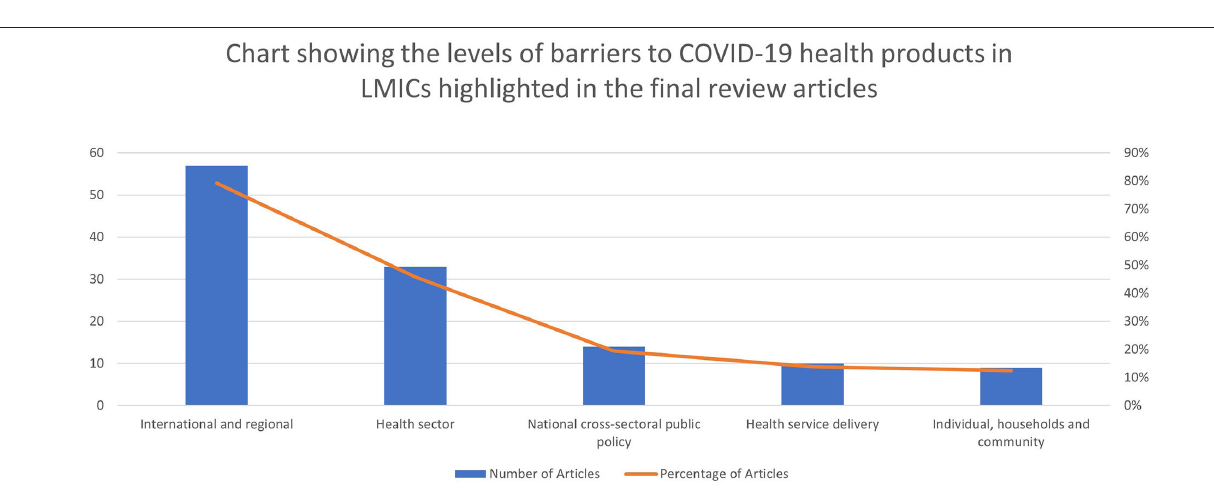
FIGURE 4 | Chart showing the levels of barriers to COVID-19 health products in LMICs highlighted in the final review